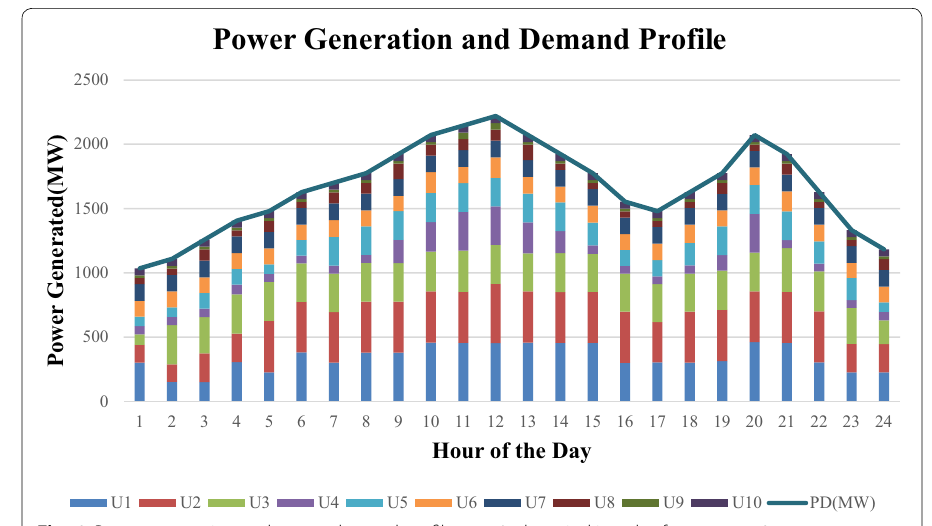
Fig. 6 Power generation and power demand profile over 24-h period in a day for test case 3